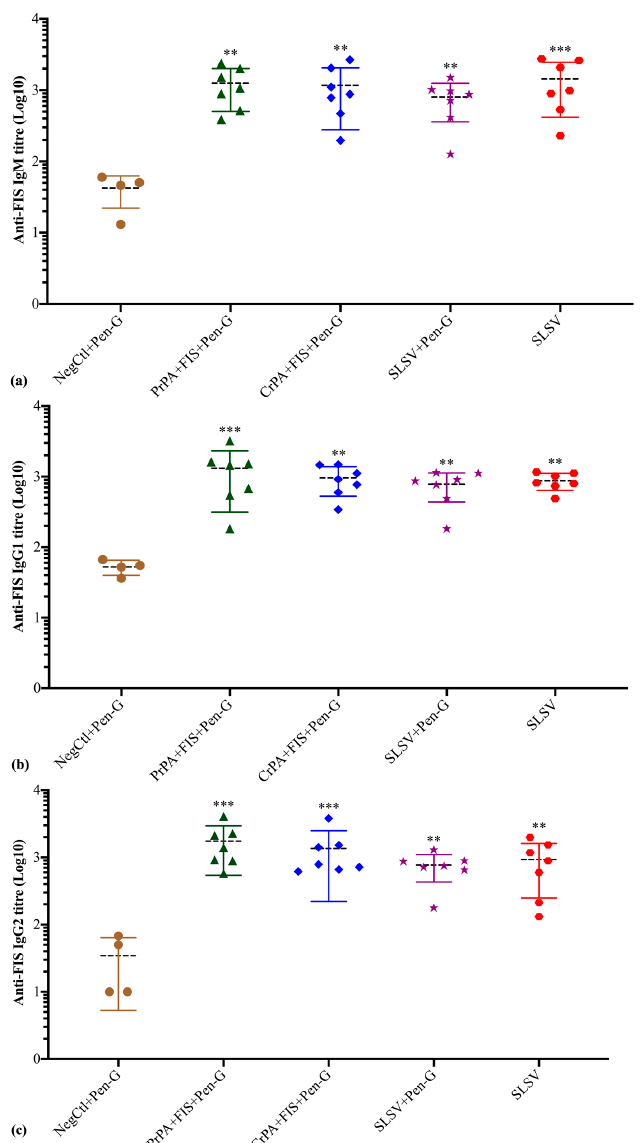
Figure 5. Anti-formalin inactivated Bacillus anthracis 34F2 spores (FIS) IgM and IgG isotypes (IgG1 and IgG2) titres at week 5 in cattle. The cattle were vaccinated twice at weeks 0 and 3 with PrPA + FIS + Emulsigen-D ® / Alhydrogel ® plus Pen G ( n = 7), CrPA + FIS + Emulsigen-D ® / Alhydrogel ® plus Pen G ( n = 7), Sterne live spore vaccine (SLSV) plus Pen-G ( n = 7), SLSV ( n = 7) and NegCtl (Emulsigen-D ® / Alhydrogel ® plus Pen G) ( n = 4). The IgG titres of each group were compared to the respective titres at week 0 before vaccination (*** p < 0.001, ** p < 0.01, * p ≤ 0.05). ( a ) anti-FIS IgM titres, ( b ) anti-FIS IgG1 titres and ( c ) anti-FIS IgG2 titres. Purified recombinant protective antigen: PrPA; Crude recombinant protective antigen: CrPA; Formalin inactivated Bacillus anthracis spores: FIS; Penicillin-G: Pen-G; Sterne live spore vaccine: SLSV; Negative control: